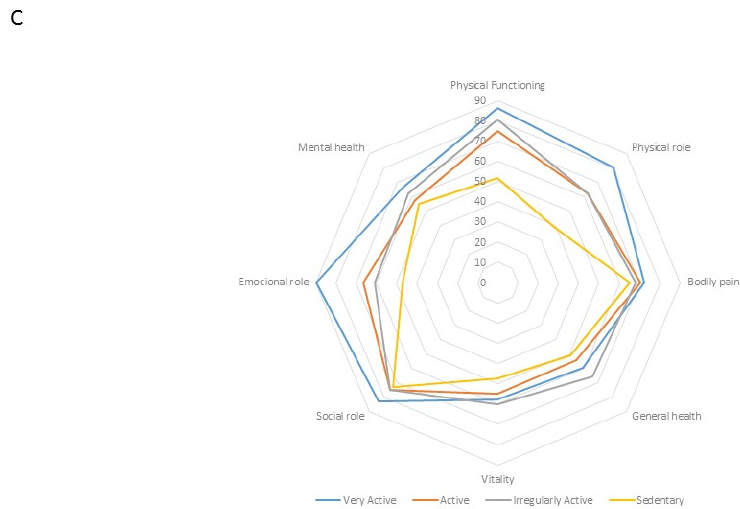
Figure 1. ( A ). Comparison between the SF36 values of JIA patients and the control group. Significant differences were found in all domains ( p < 0.001 for all analyses except bodily pain ( p = 0.003) and social role ( p = 0.015)). ( B ): JIA. Comparison between the mean values of the SF36 variables of each classification element of the physical activity level according to the IPAQ. ( C ): Controls. Comparison between the mean values of the SF36 variables of each classification element of the physical activity level, according to IPAQ. Both the frequency ( p = 0.003; r = 0.071) and the weekly duration ( p = 0.017; r = 0.029) of vigorous physical activity were positively correlated with the physical component of the SF36 (Table 5).